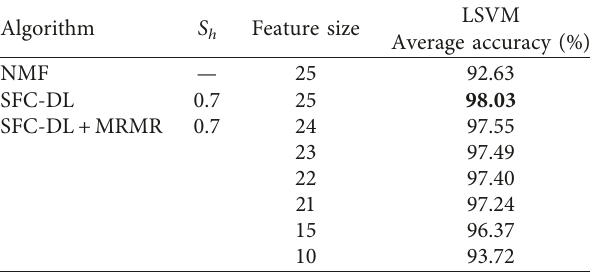
Table 2: The results of different feature extraction algorithms based on NMF.